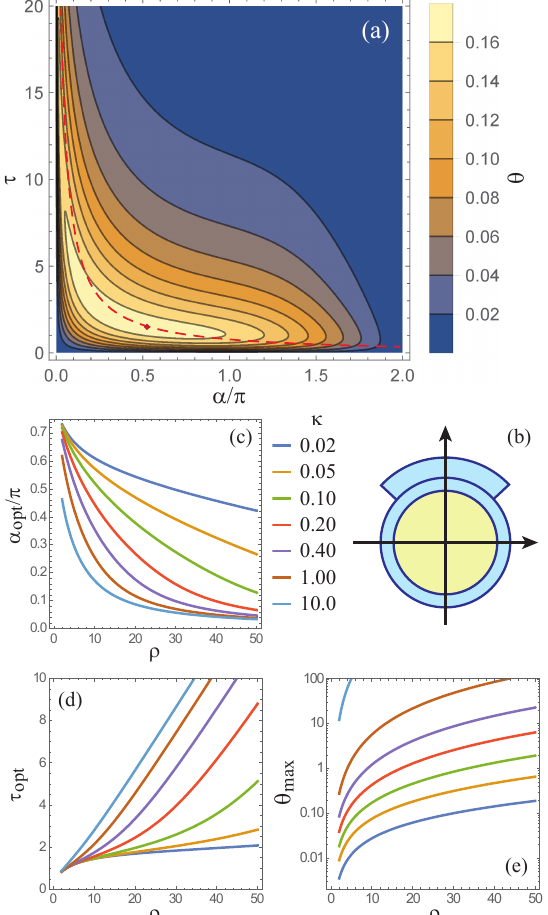
Figure 5. ( a ) Contour plot of function ϑ ( α , τ ) [Equation (12)] for κ = 0.1 and ρ = 10; ( b ) optimal actuator cross-section (with α opt ≈ 0.52 ≈ 94 ◦ and τ opt ≈ 1.49) corresponding to the maximal bending angle shown by the open circle in (a); and ( c )–( e ) optimal α and τ and the maximal bending angle ϑ max = ϑ ( α opt , τ opt ) as functions of ρ for different κ . In all cases it was assumed that R = L